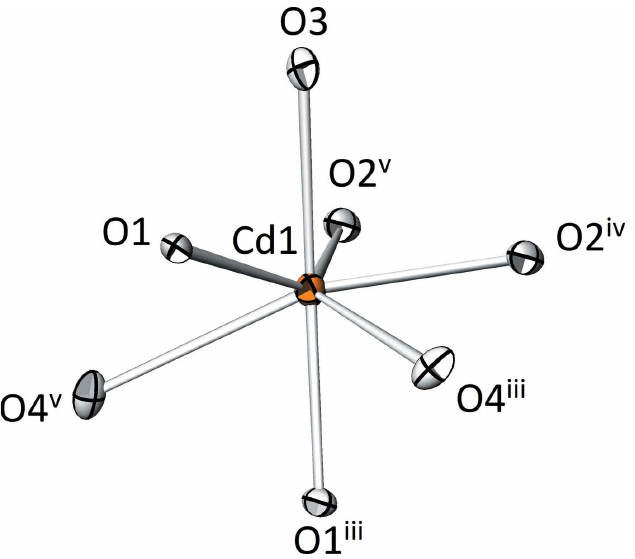
Figure 2 The [TeO 4 ] polyhedra in the crystal structure of (cid:2) -CdTe 2 O 5 . Displace- ment ellipsoids are drawn at the 90% probability level. Symmetry codes refer to Table 1.